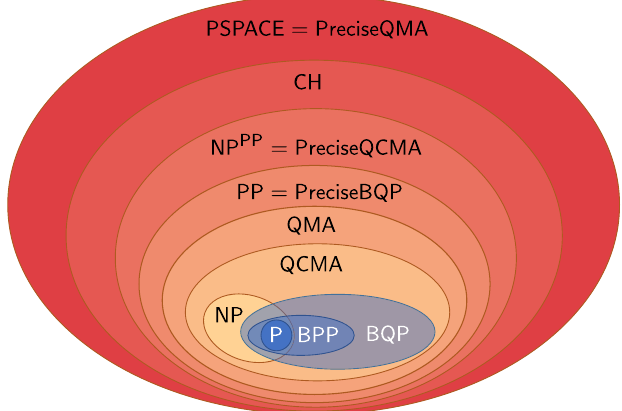
FIG. 1. Major complexity classes featuring in this work. PSPACE , NP PP , and PP can be defined purely in terms of quantum computation, and are equal to PreciseQMA , PreciseQCMA , and PreciseBQP , respectively. All inclusions except P ⊆ BPP are believed to be